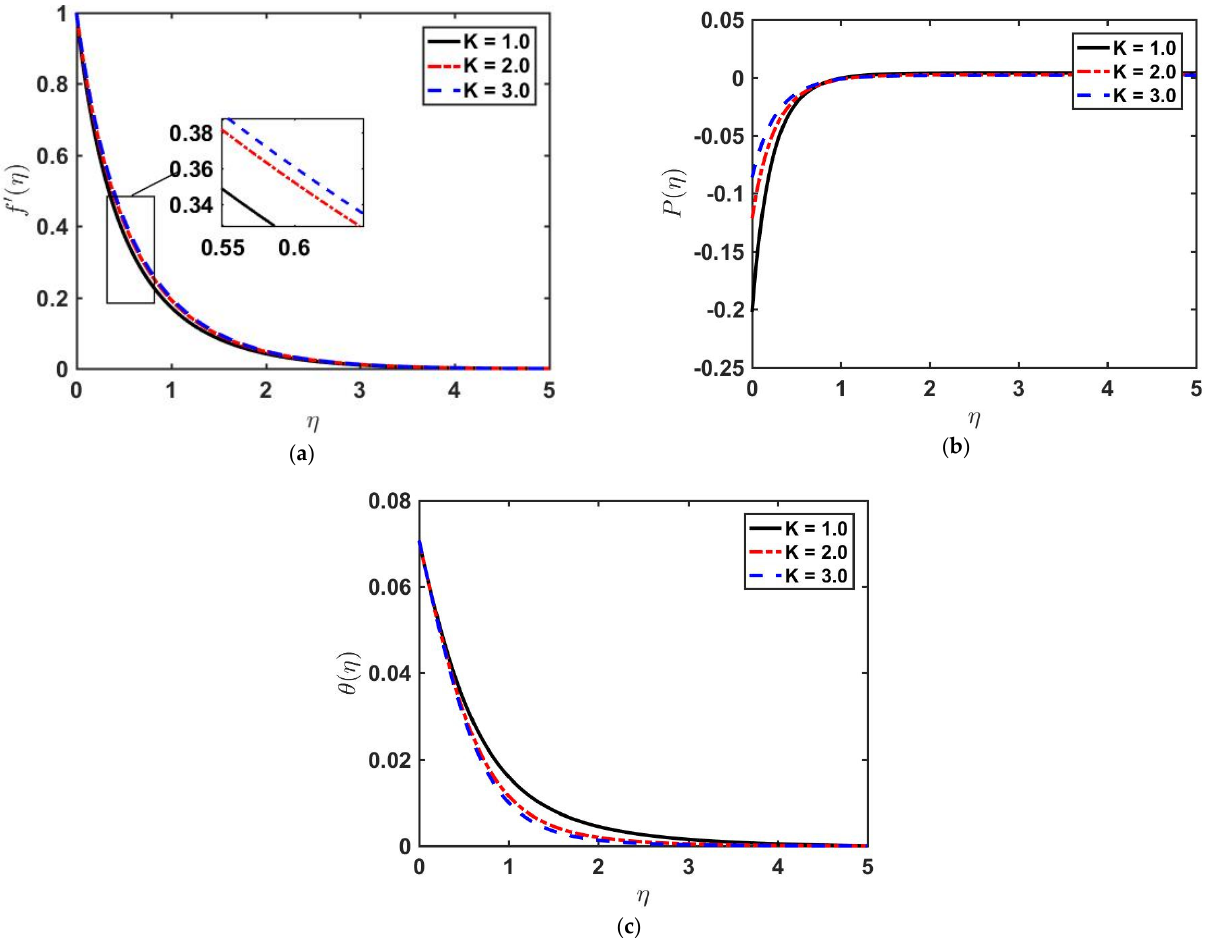
Figure 3. Effect of K on ( a ) f (cid:48) ( η ) , ( b ) P ( η ) , and ( c ) θ ( η )